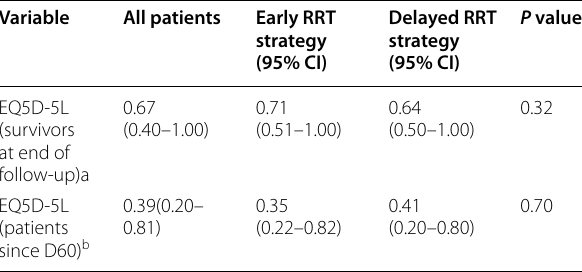
Analysis of the survivors was led on the 80 patients who responded to the questionnaire. Analysis of patients since D60 was led on 170 patients (90 patients who died after D60 and 80 patients who responded the questionnaire). Index values are a summary of the 5 dimensions described in the manuscript a All Index Values represented are medians. Interquartile ranges are in () b Including deceased patients. Death was also treated as an event because the EQ-5D index value of deceased patients is normally considered to be The occurrence of WRF did not differ according to RRT initiation strategy (Fig. 3B). In the univariate Fine and Gray analysis, no variable was associated with the occurrence of WRF (Table 3).